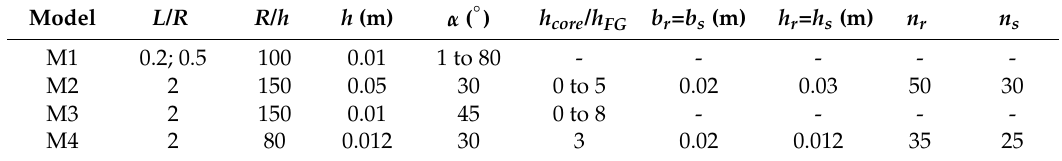
Table 1. The geometric properties for the stiffened (un-stiffenedt) truncated conical shells.